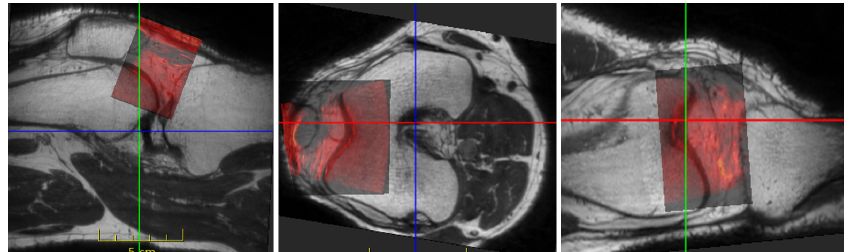
Figure 7. Final registration output of Subject 5: US aligned on respective MRI.